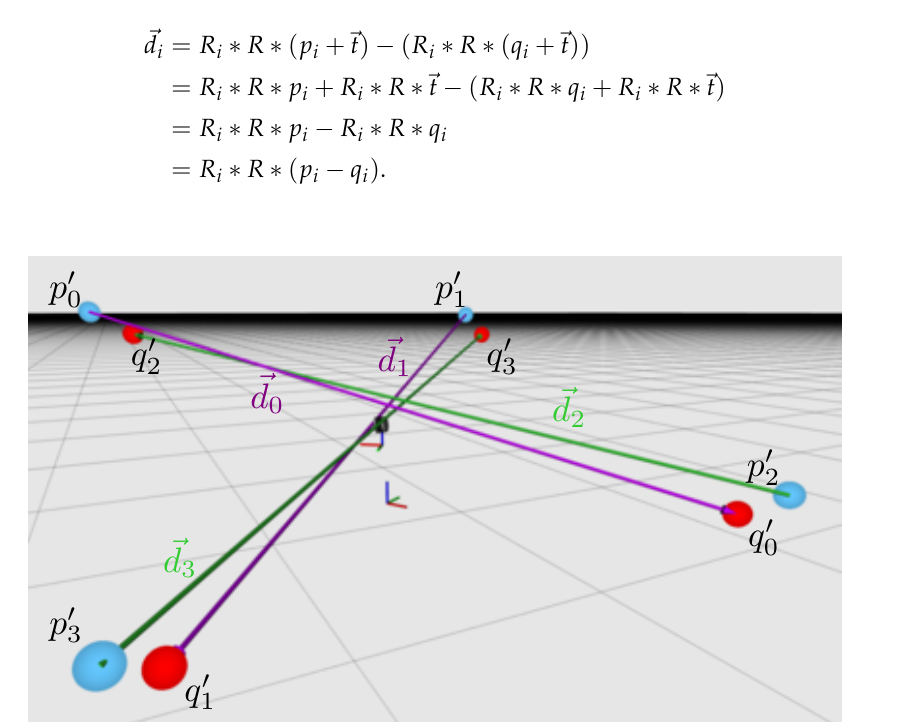
Figure 4. Direction-vectors between (e.g., (cid:126) d 1 and (cid:126) d 3 ) become anti-parallel if the rotation is well known. The picture shows an exemplary target arrangement using M = 4 spheres. The depicted vectors indicate that the platform is not yet